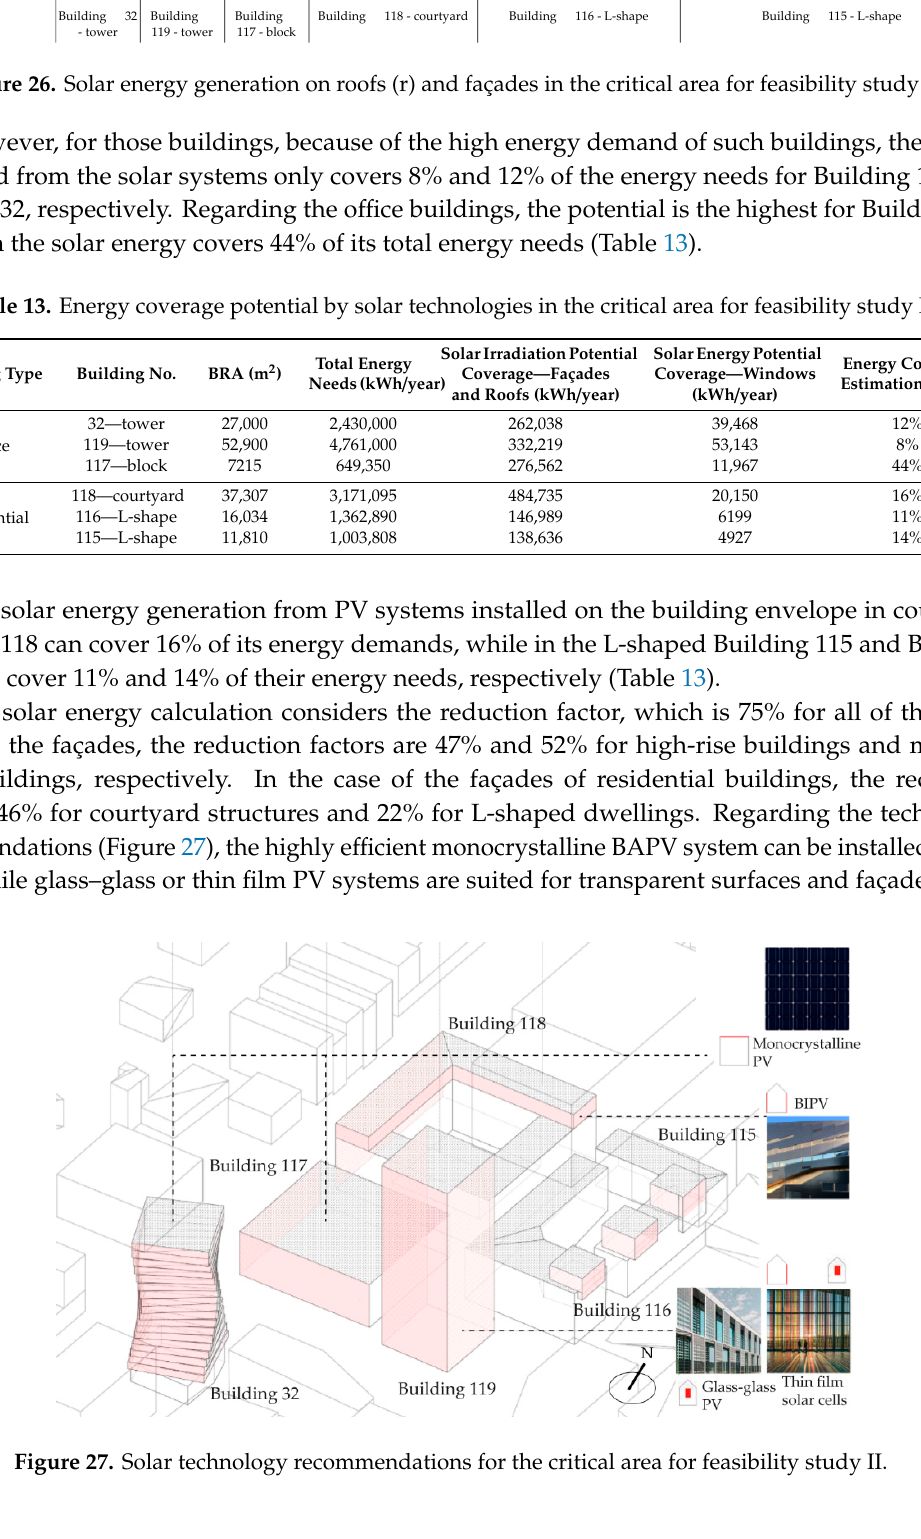
Figure 27. Solar technology recommendations for the critical area for feasibility study II.